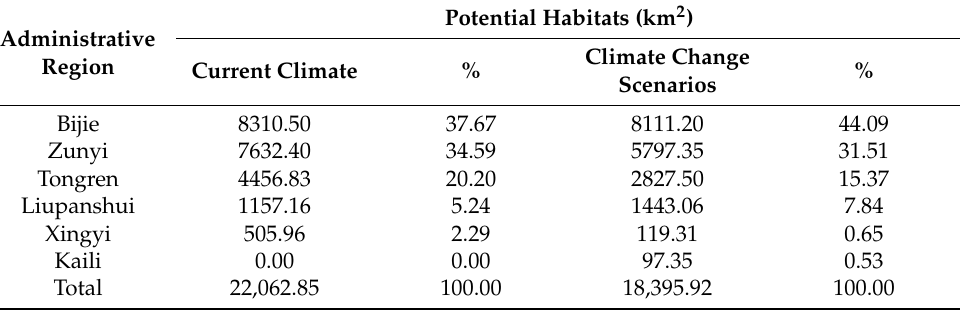
Table 1. Areas of the potential habitats under current climate and future climate change scenario (RCP